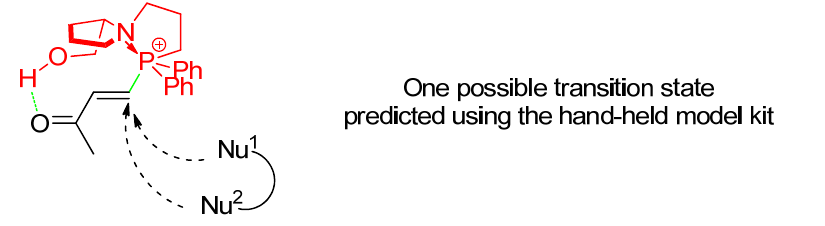
Figure 4. Proposed conformation of an intermediate stabilized through intramolecular hydrogen bonding and intramolecular anchimeric